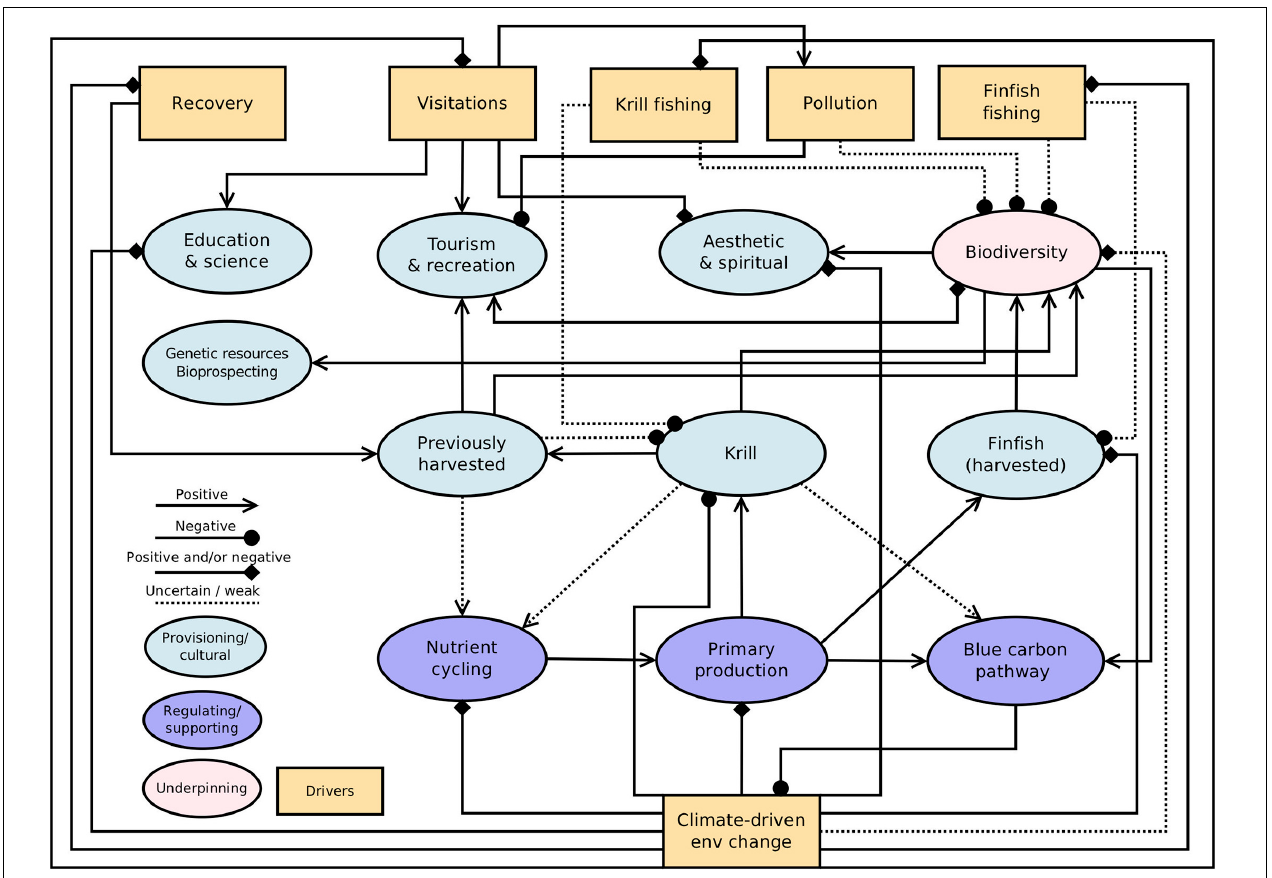
FIGURE 2 | Network representation of the links and feedbacks between ecosystem services and drivers. Connections between components indicate the direction of effects from one node to another, as indicated in the legend. Diamonds indicate cases where the direction of the effect is not known or unclear (i.e., it could be positive and/or negative), and dashed lines represent uncertain or weak linkages. The effect of fishing on associated ecosystem services (krill and finfish) is represented as weak, because we assume that current management is effective in minimising the impact of fishing on the capacity of stocks to continue to deliver ecosystem services. Services and key drivers included in the network are summarised from Supplementary Table S2 and grouped as provisioning and cultural or regulating and supporting. Biodiversity is represented as underpinning ecosystem services (and also includes ecosystem structure and processes) but can be directly affected by drivers, with consequent effects for services. Bioprospecting refers collectively to biochemicals, medicines, and pharmaceuticals. Changes to drivers have cascading effects to ecosystem services, including feedbacks across other linked